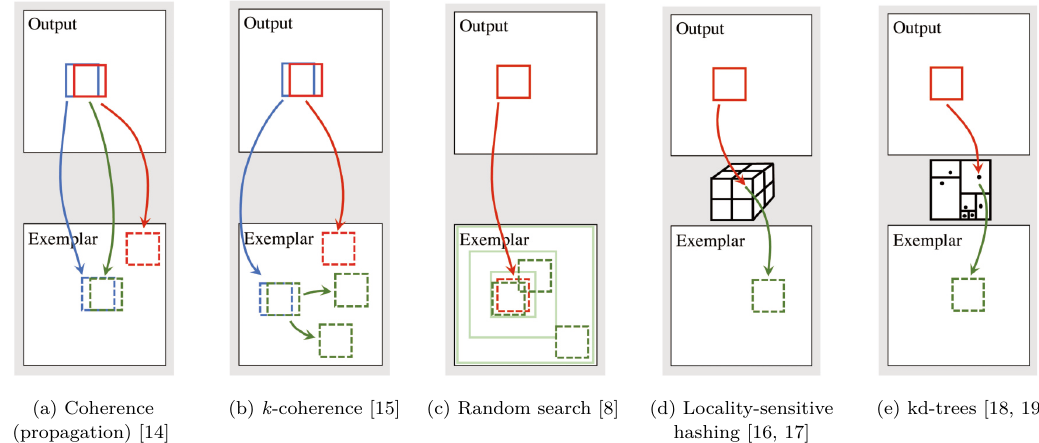
Fig. 4 Key components of different approximate matching algorithms. The goal of a matching algorithm is to establish correspondences between patches in the output image and patches in the exemplar. Each algorithm proposes one or more candidate matches, from which the match with minimal patch distance is